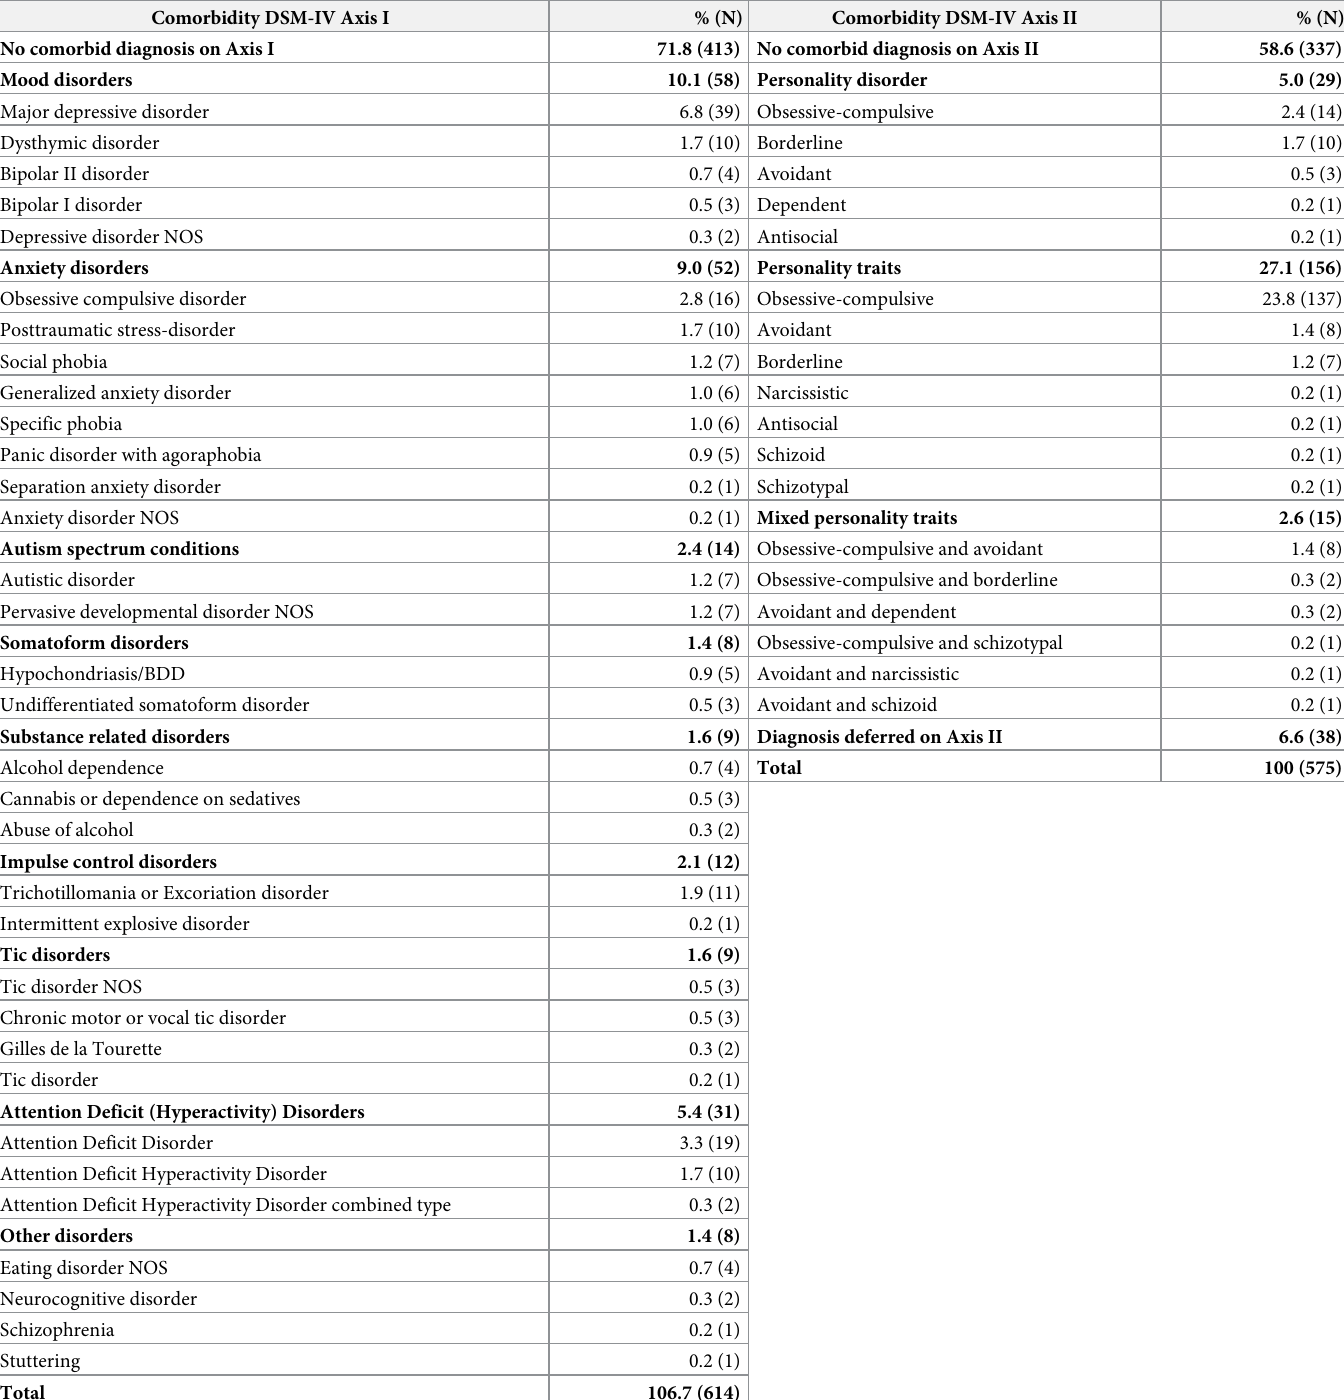
Table 2. Percentage and absolute frequencies of current DSM-IV Axis I & Axis II disorders in misophonia